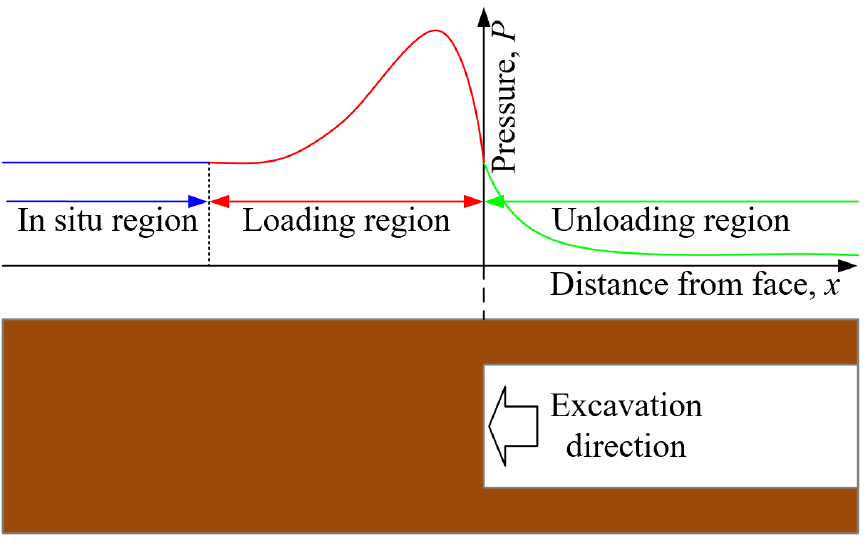
Figure 1. Schematic diagram of stress distribution during the excavation period